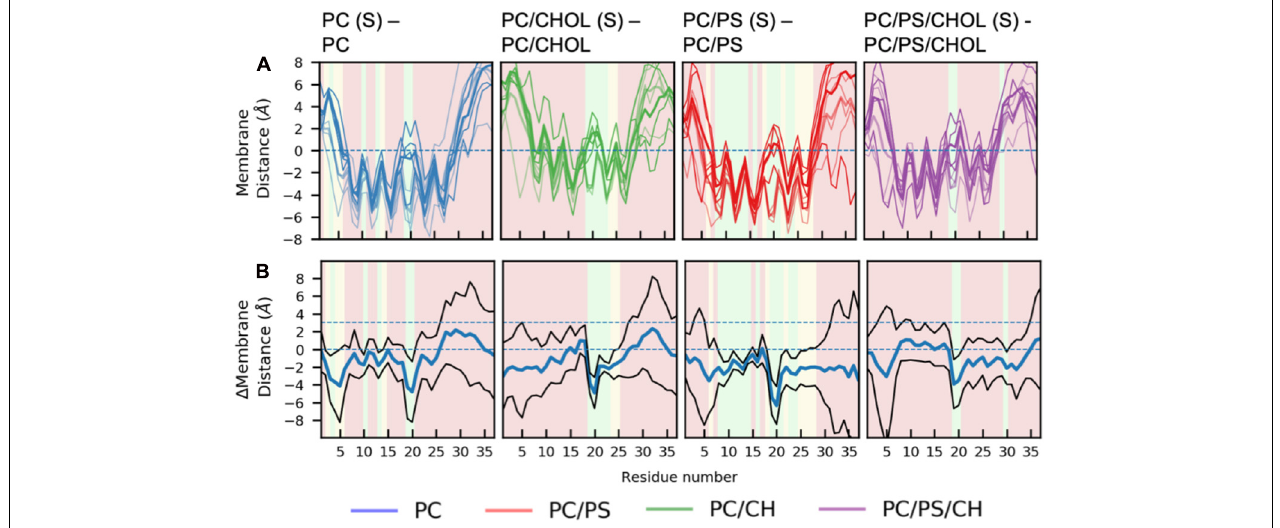
FIGURE 7 | Comparison of membrane positions of straight and kinked IAPP relative to the membrane. (A) Position of C α of the peptide relative to the phosphate plane, colored as in Figure 5 . (B) Differences between the peptide insertion in the kinked and the straight IAPP, colored as in Figure 6 .